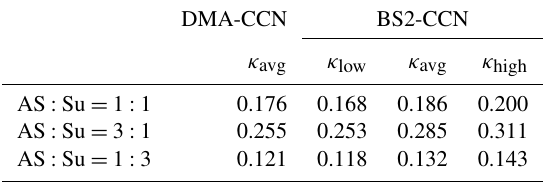
Table 2. κ avg from DMA-CCN and κ low , κ avg , and κ high from BS2- CCN measurements for the d T = 8K ( S = 0 . 63%) condition for mixtures of ammonium sulfate and succinic acid. κ low and κ high are derived from the range of calibration curves in Fig.